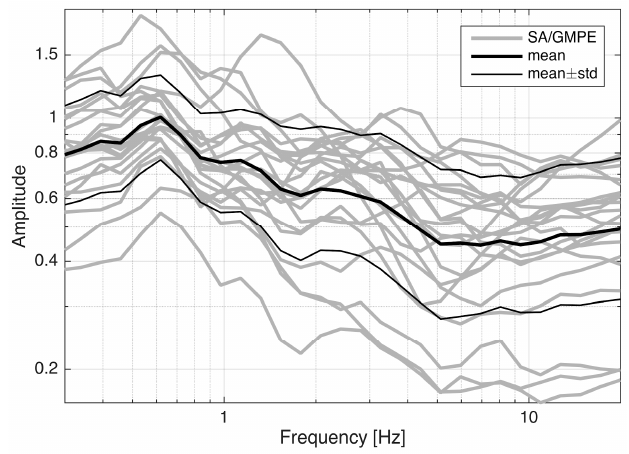
Figure 7. Single-station mean normalized spectra related to the lowest amplification with the ITA10 EC8-A response spectra.